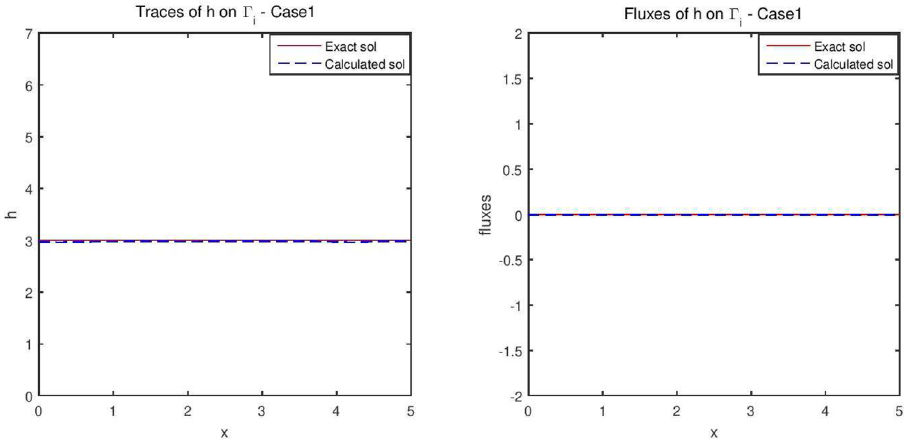
Figure 2. The reconstructed flow—Case 1.